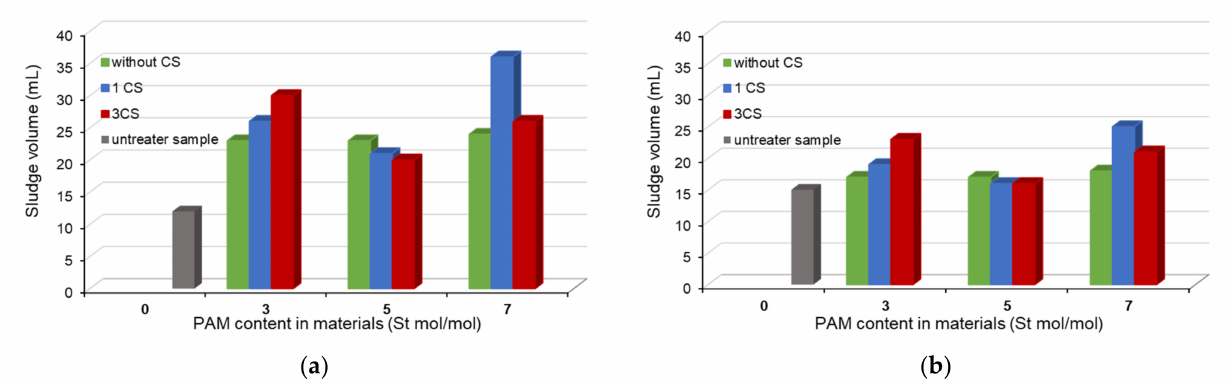
Figure 11. Sludge volume changes during the flocculation tests for a kaolin aqueous suspension dependent on the flocculants in 3 mL dose after: ( a ) 20 min and ( b ) 100 min of the test